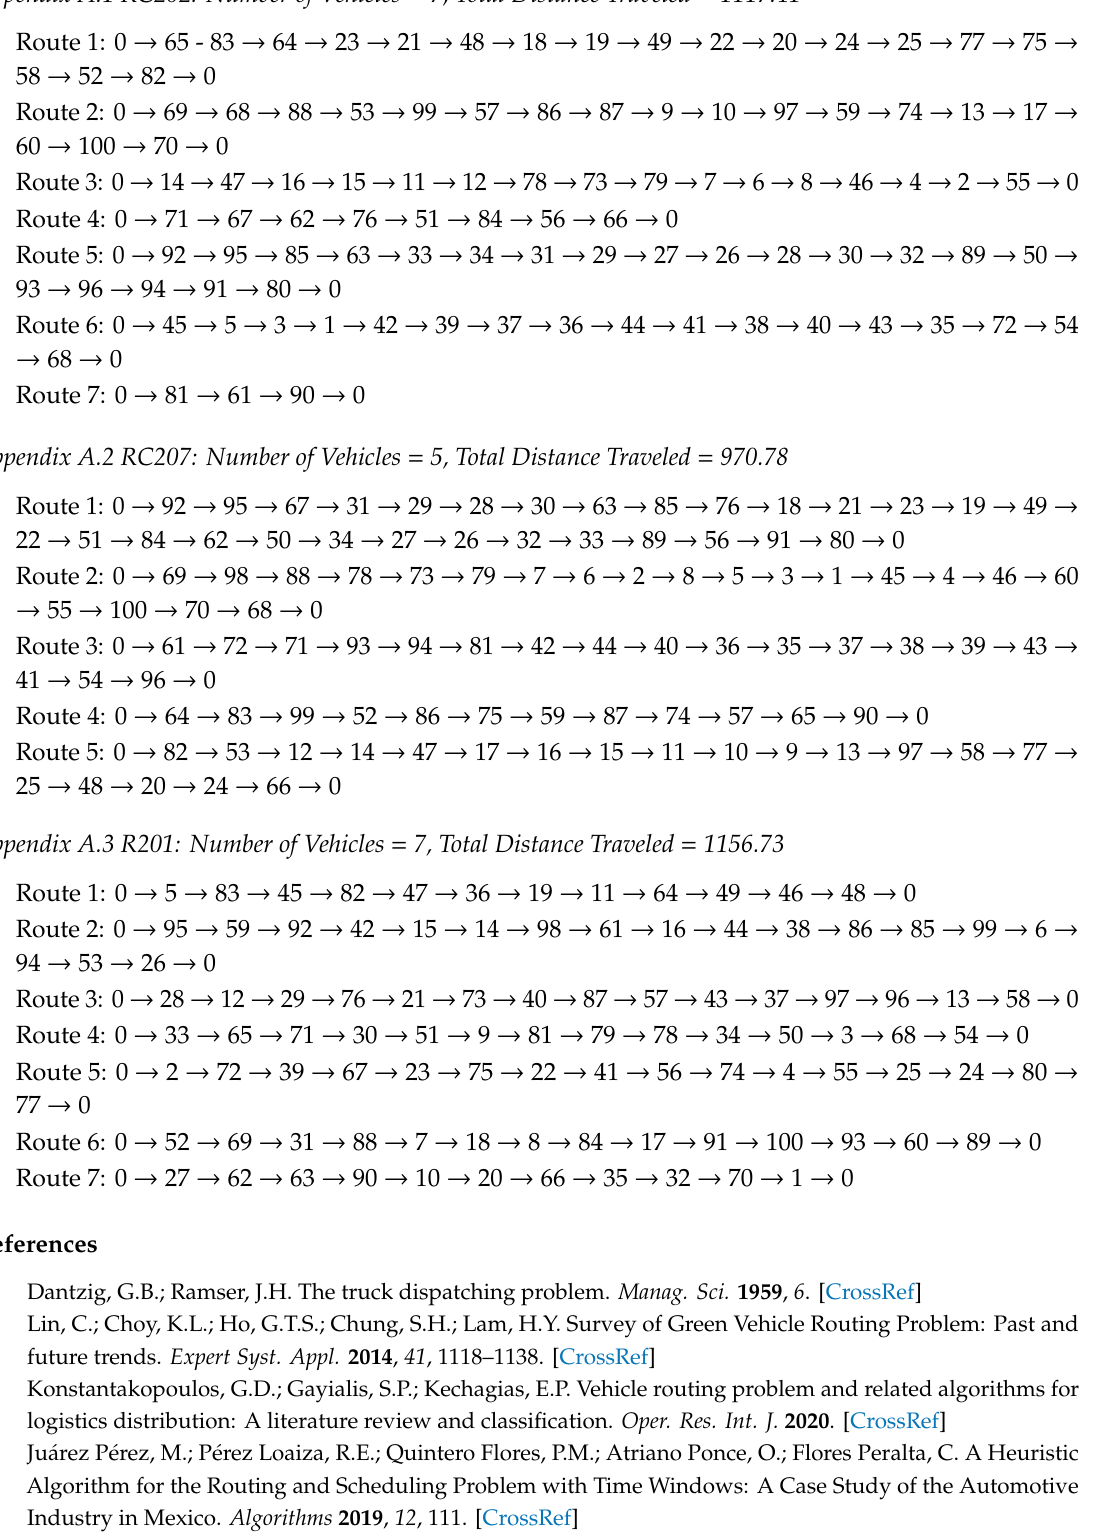
Algorithm for the Routing and Scheduling Problem with Time Windows: A Case Study of the Automotive Industry in Mexico. Algorithms 2019 , 12 , 111.